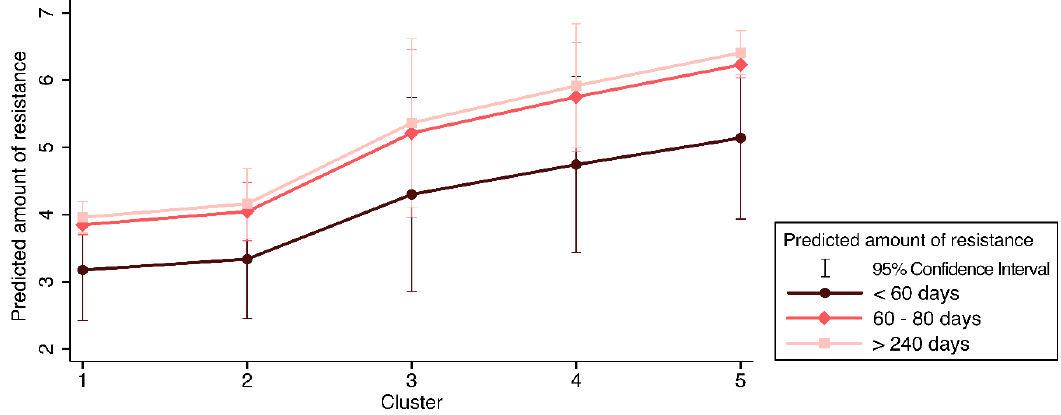
Figure 6. Predicted counts of resistance estimated considering the clusters and time on farm of the animal categories. Legend: error bars = 95% Confidence Interval of the predicted mean.